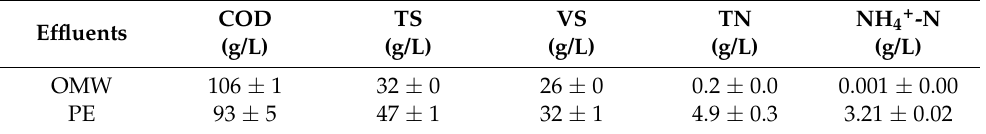
Table 2. Effluents: Chemical composition.